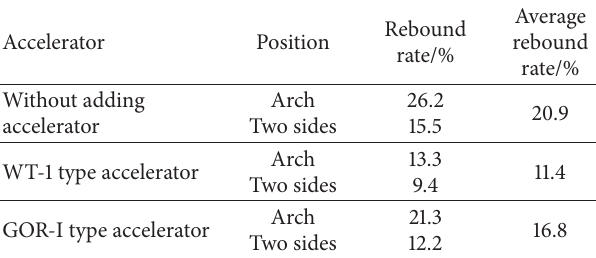
Table 15: Rebound rate of